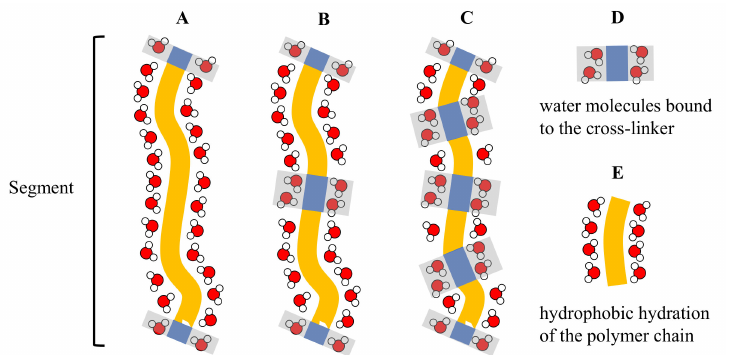
Figure 5. Schematic representation of the water molecules attached to an arbitrary polymer segment. It is assumed that the water molecules bound to the monomer units E leave the segment at the VPT while the water molecules bound to the cross-linker D remain at their position because the cross-linker has no LCST. Segment A contains only one cross-linker. In segment B the concentration of the cross-linker is two times higher and in segment C it is four times higher than in segment A. The number of water molecules that leave the microgel per segment at the VPT should decrease linearly with the increase of the cross-linker